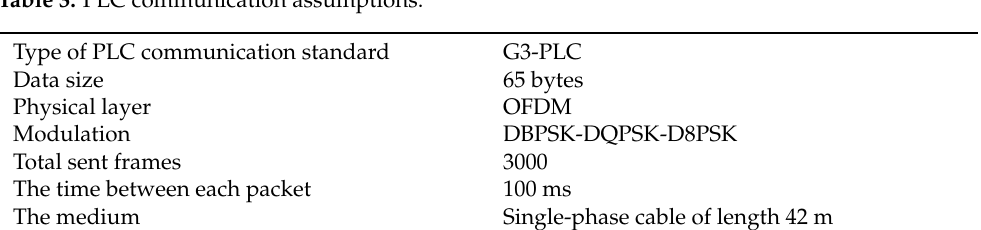
Table 3. PLC communication